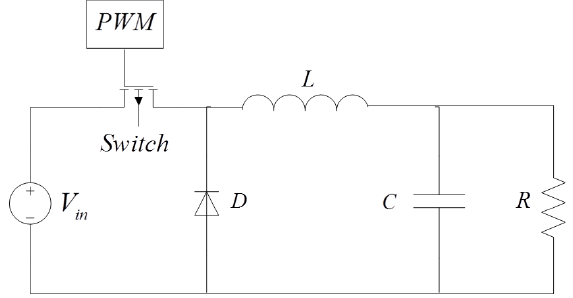
Figure 1. DC/DC Buck converter.